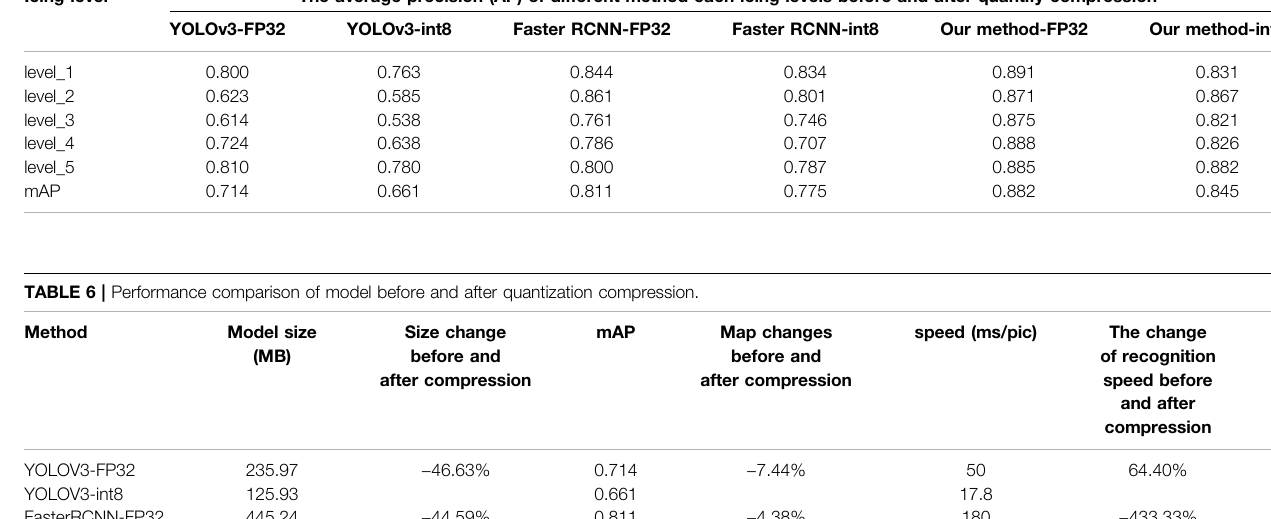
TABLE 5 | The mean accuracy of different method before and after quantify compression. Icing level The average precision (AP) of different method each icing levels before and after quantify compression